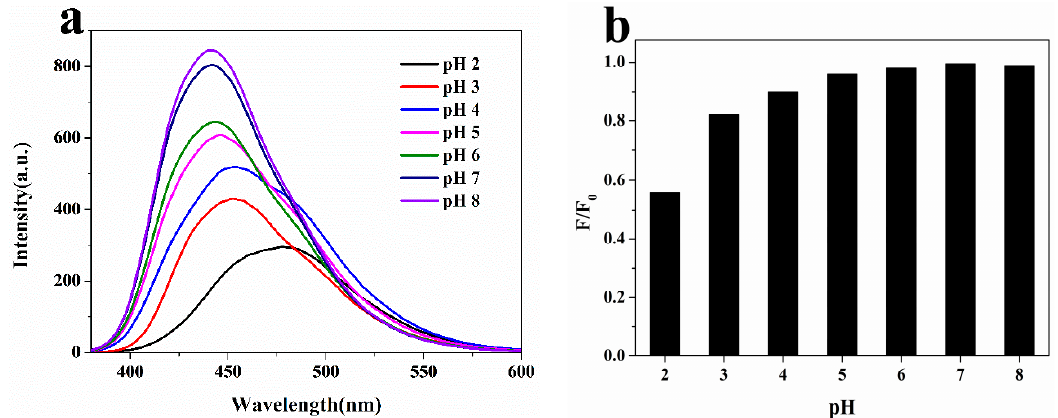
Figure 4. ( a ) The effect of pH (2.0, 3.0, 4.0, HCl-KCl buffer solution and 5.0, 6.0, 7.0, 8.0, PBS) on the fluorescence intensity of N-CQDs solution; ( b ) The effect of pH (2.0, 3.0, 4.0, HCl-KCl buffer solution and 5.0, 6.0, 7.0, 8.0, PBS) on the quenching of the fluorescence intensity of N-CQDs solution in the presence of nitrite (10 − 5 M) with a time duration of 15.0 min measured at room temperature.